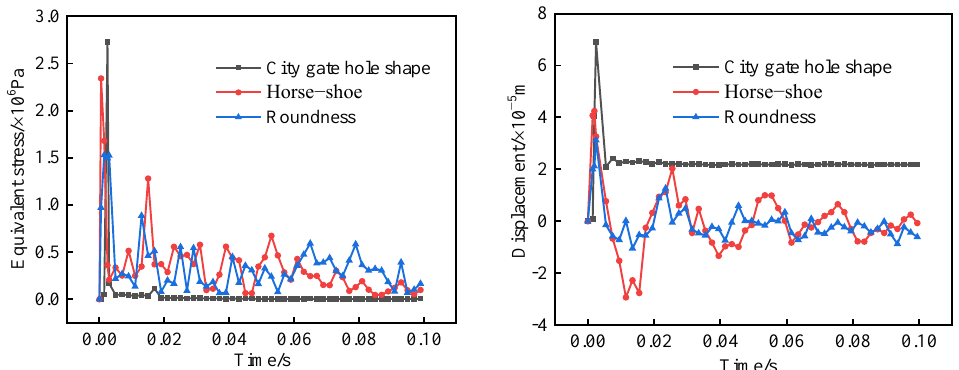
Figure 18. Time – history curves of equivalent stresses ( left ) and X -displacements ( right ) for different cross-sections.